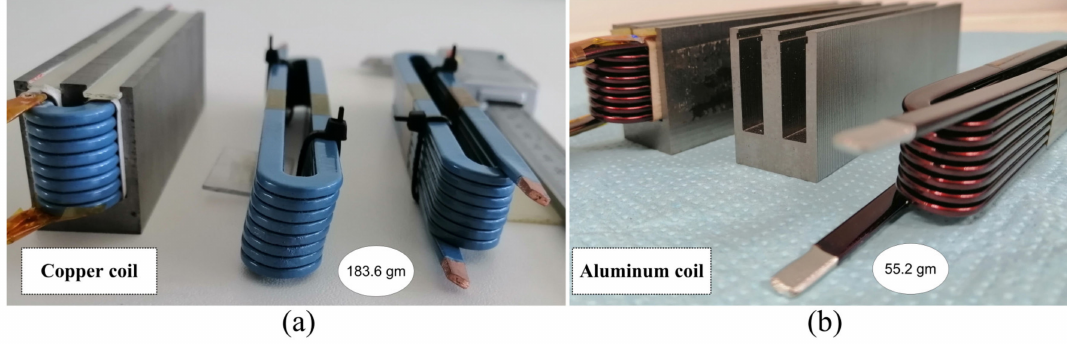
Figure 1. Flat magnet wires [7]. ( a ) Copper; ( b )